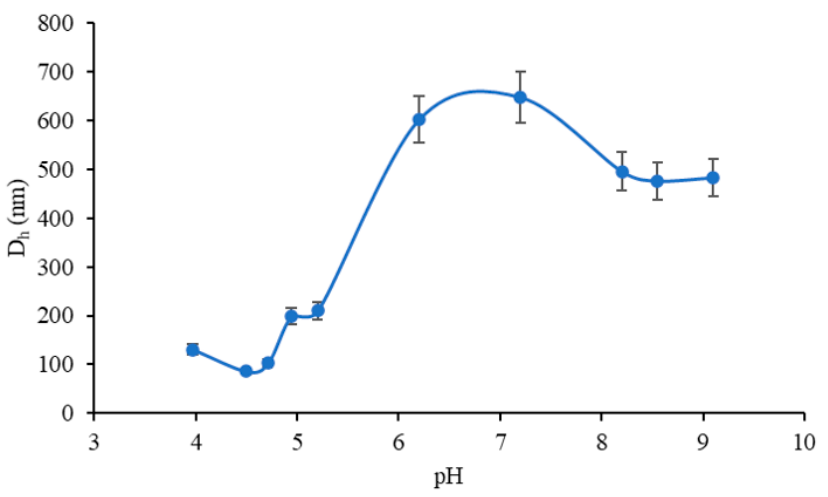
Figure 9. Variation of BSA / MAC nanogel D h with pH.